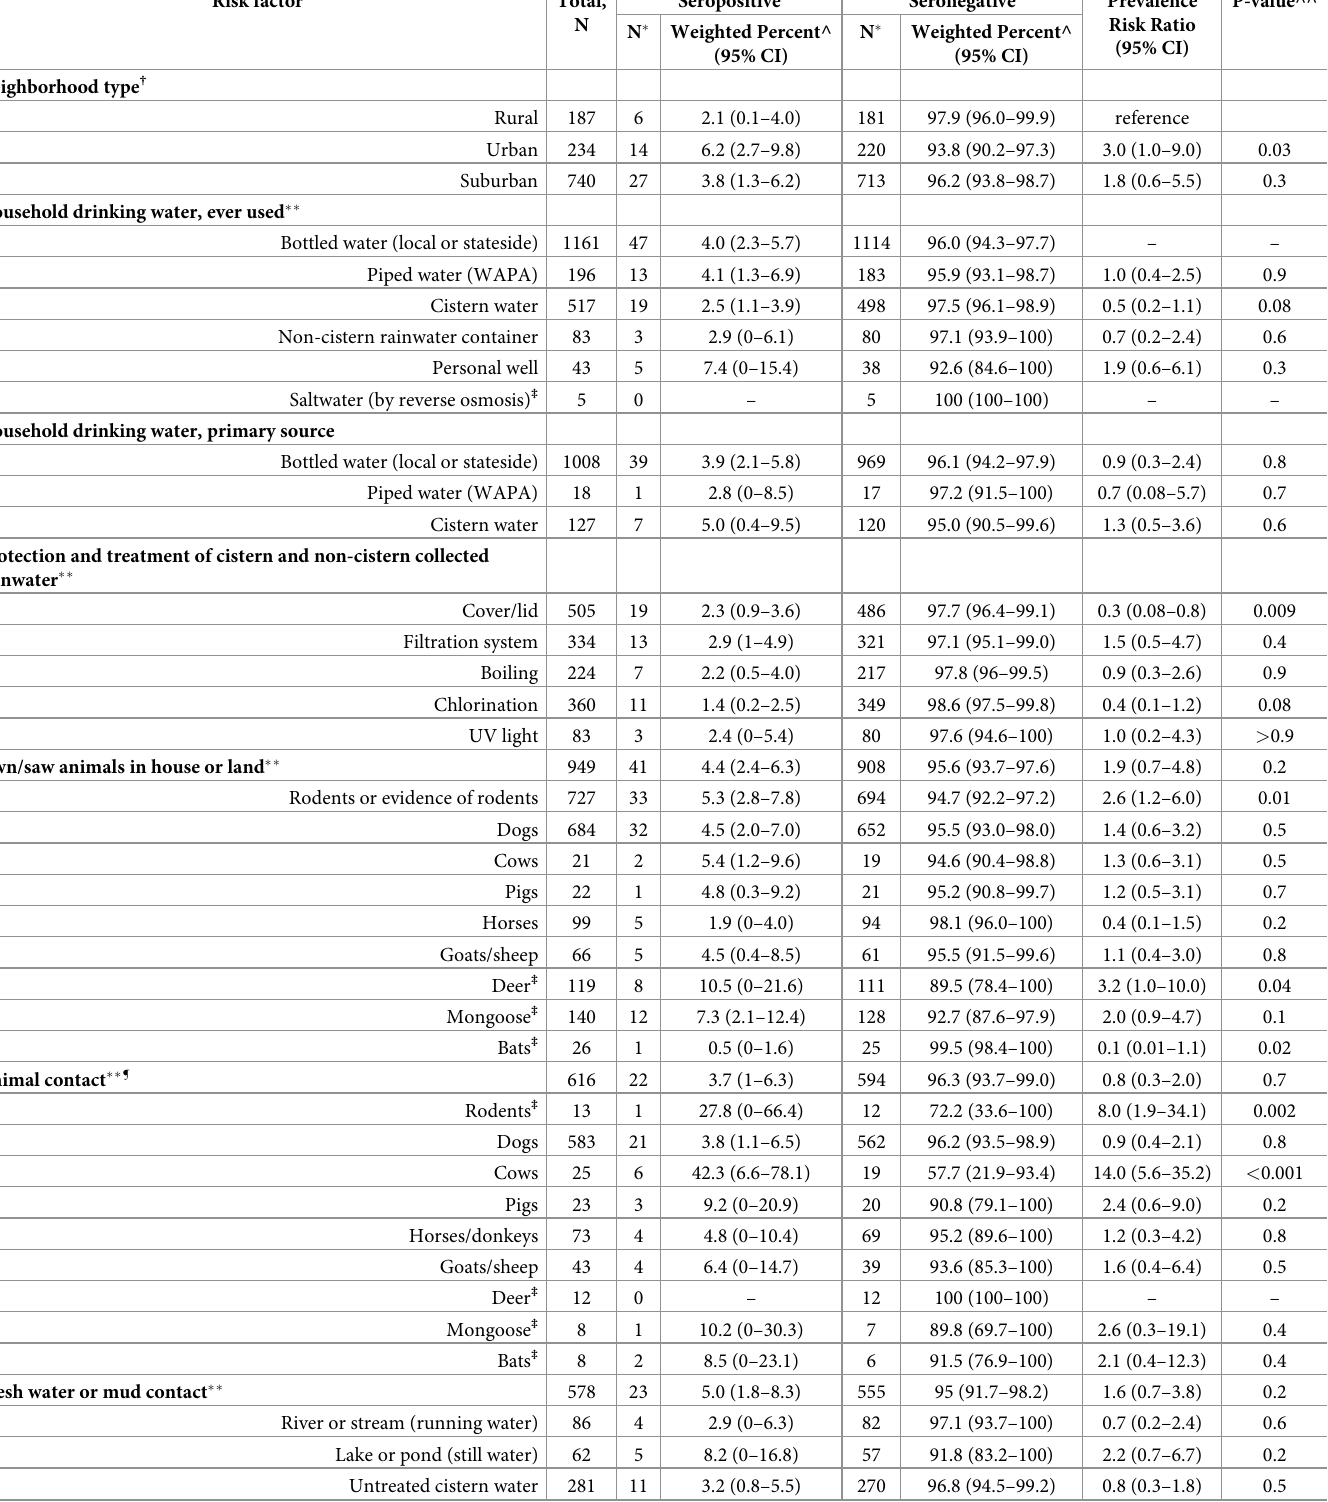
Table 2. Household and Individual Exposures and Risk Factors of Leptospirosis Serosurvey Participants in USVI by Serology Result, March